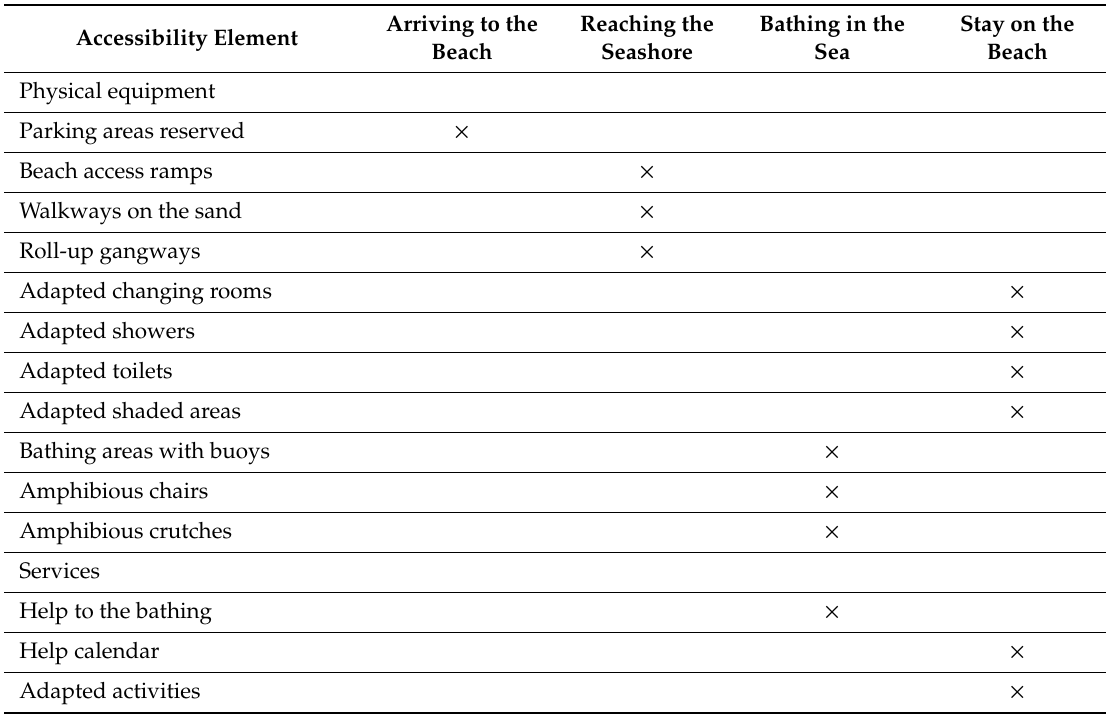
Table 1. Classification of the elements of accessibility to the beaches.